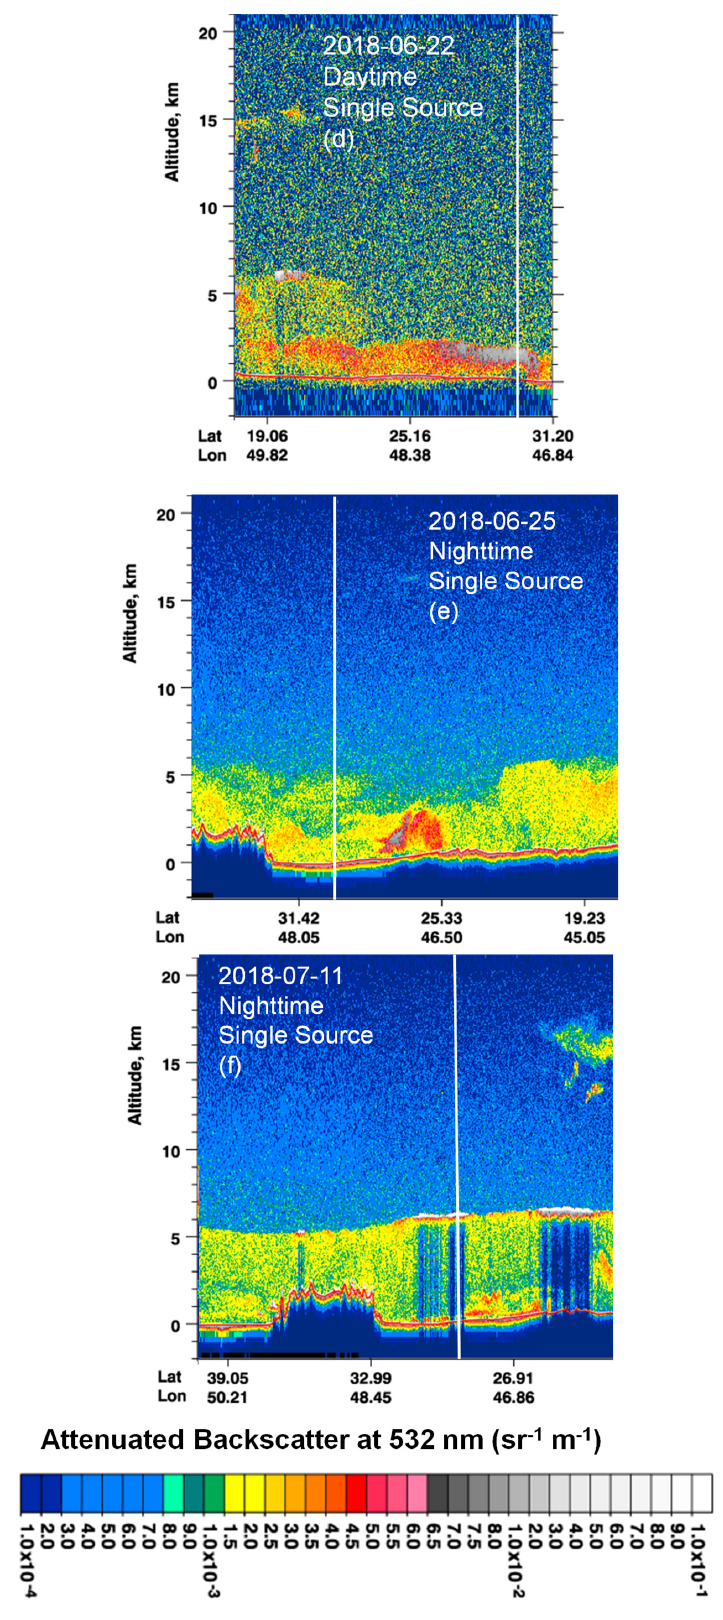
Figure 5. ( a – f ) show the effect on Kuwait City of the dust from a single source. ( a ) A nighttime image of the 532 nm showing an extensive layer of dust right around Kuwait City. ( b ) A daytime